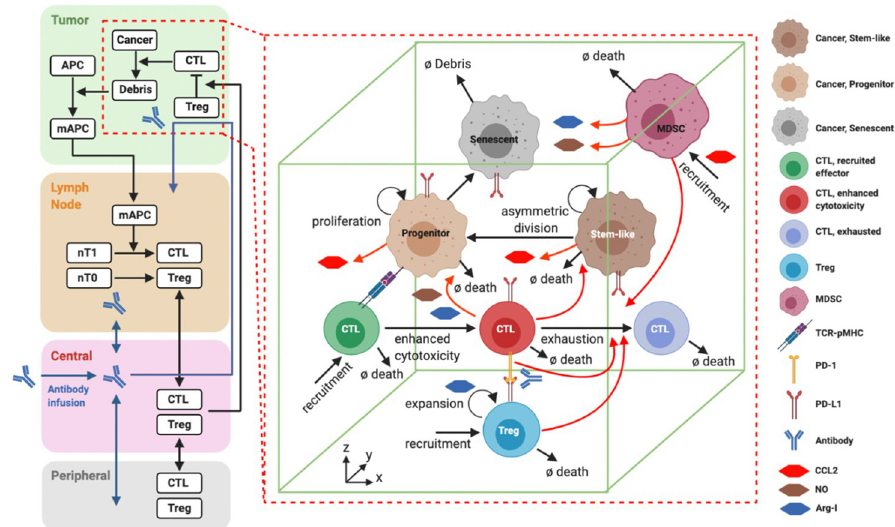
Fig 1. Diagram of the spQSP model. Left: Compartmental representation of the whole patient by QSP model. Right: Spatial representation of the tumor by ABM. Some deterministic species and reactions from the QSP tumor compartment are replaced with equivalent agents and stochastic reactions in ABM. The antigen module, however, is not explicitly represented in ABM. It consists of antigen-presenting cells that mature after taking antigens from the tumor compartment to transport them through lymphatic vessels to the tumor-draining lymph node compartment. Once there, they prime na ï ve cytotoxic T lymphocytes (CTL) and regulatory T cells (Treg) that clonally expand in the tumor draining lymph nodes, intravasate, circulate through the central compartment (blood system), and extravasate into the tumor microenvironment as described in [1]. The figure has been created with Biorender.